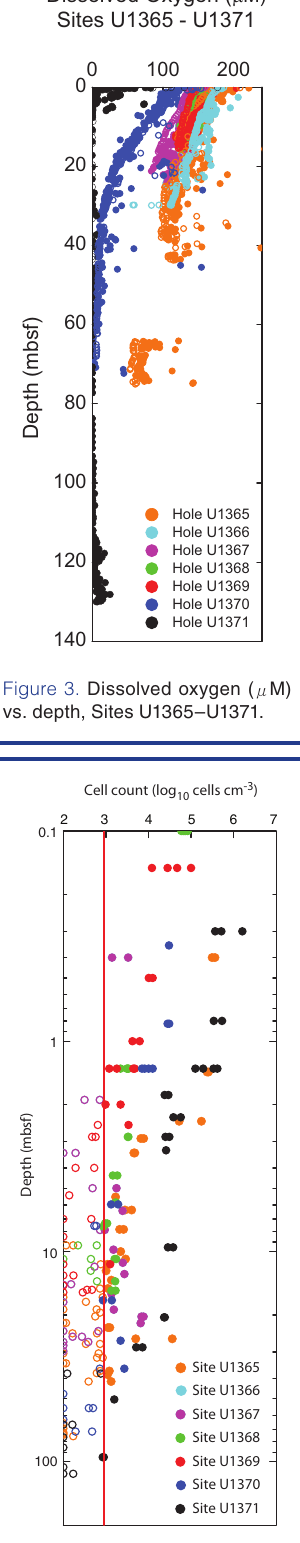
Figure 4. Cell counts vs. depth, Sites U1365–U1371, data from D’Hondt et al., 2011a. The vertical red line is the minimum detection limit (MDL). The filled symbols represent counts above the MDL and the open symbols represent counts below the